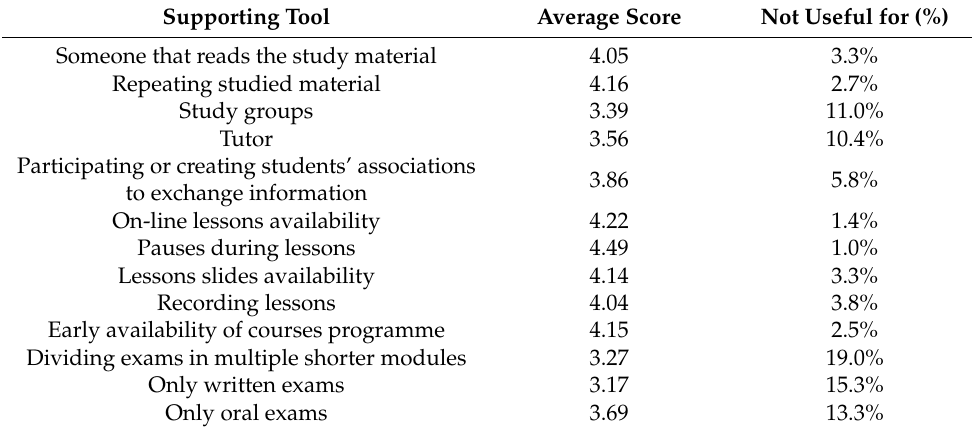
Table 7. Average score given by dyslexic students in the questionnaire to the usefulness of each supporting strategies, from 1 (very little useful) to 5 (very much useful) and percentage of students that found it